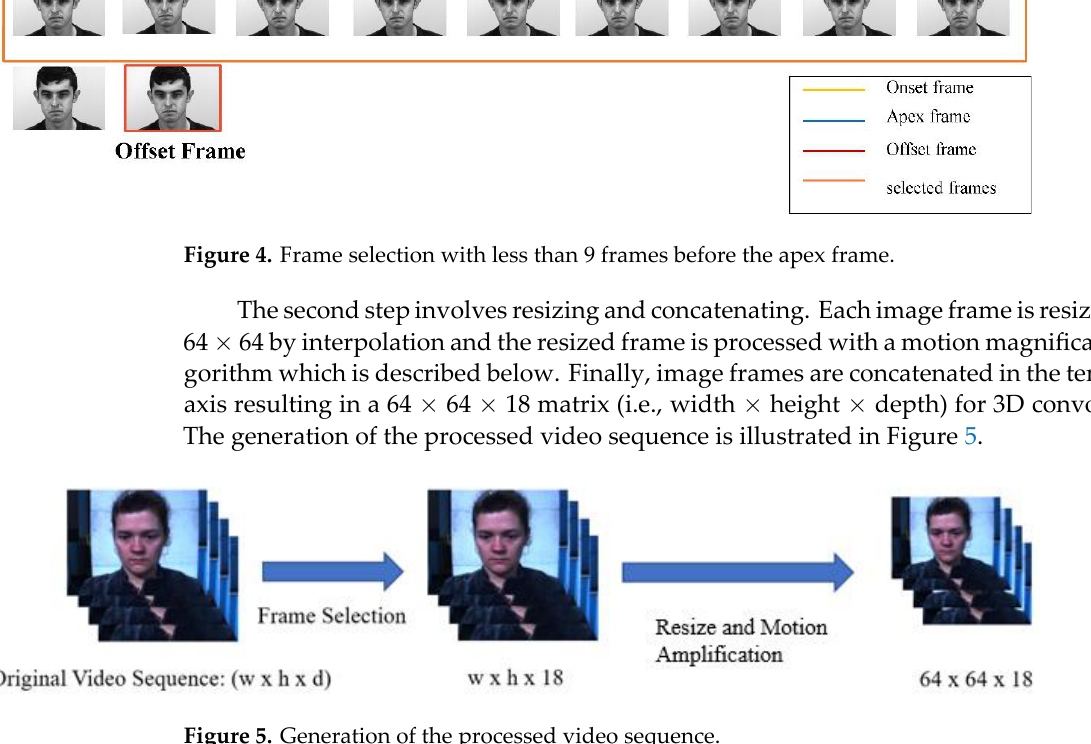
Figure 5. Generation of the processed video